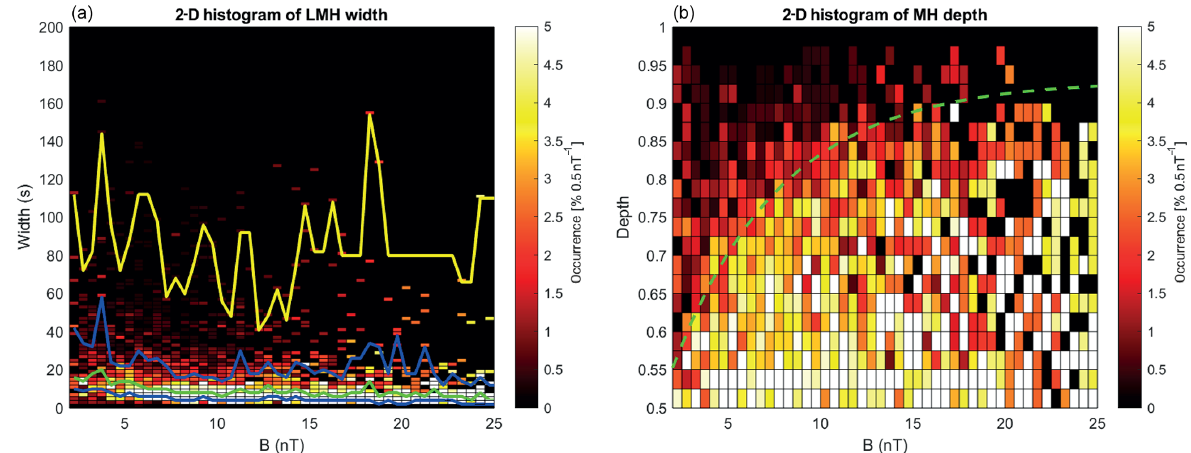
Figure 9. 2-D histogram of the occurrence rate of (a) the width (in seconds) and (b) the depth of the linear MHs as a function of the background magnetic field strength. In panel (a) the 25th (blue), 50th (green), 75th (blue), and 97.5th (yellow) percentiles are shown. In panel (b) the dashed green line is an exponential fit to the approximate upper boundary of the depth of the